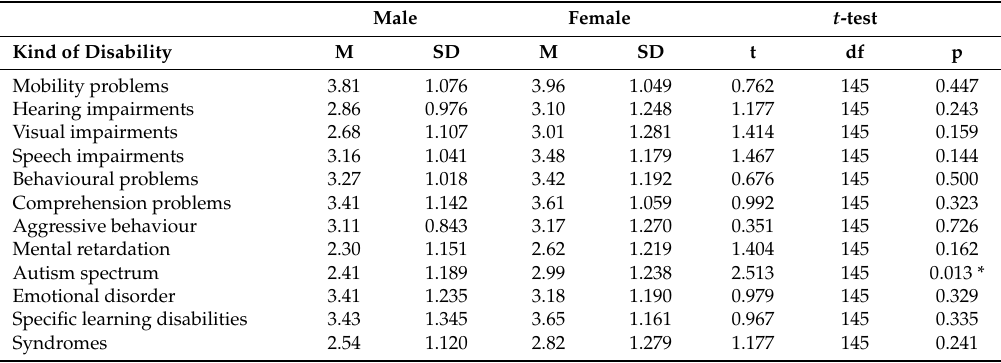
Table 4. Attitudes toward inclusion based on